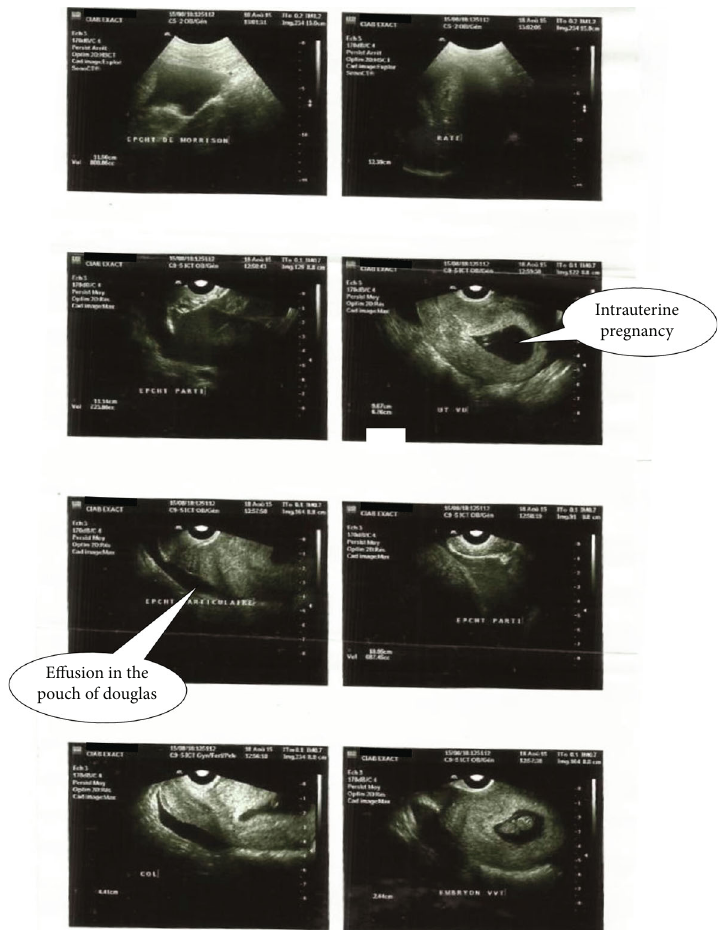
Figure 1: Ultrasound images showing intrauterine pregnancy and e ff usion in the Douglas